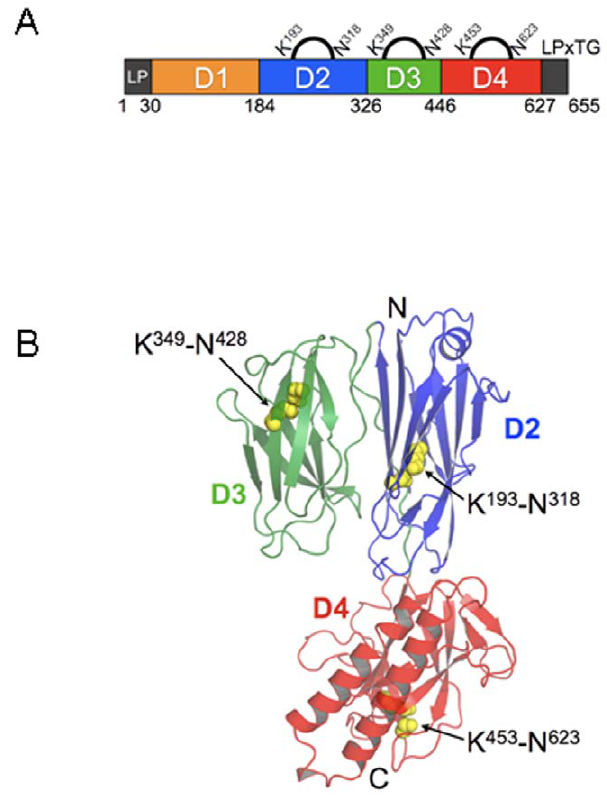
Figure 3. Structure of RrgB. A) Sequence organization of the full- length RrgB protein. D1 is depicted in yellow, while D2, D3 and D4 domains are respectively in blue, green and red. Position of the intra- molecular isopeptide bonds, the leader peptide (LP) and LPXTG motif are indicated. B) Ribbon Diagram showing the three domains of RrgB coloured as in A. Isopeptide bonds in each domain are shown as yellow spheres. Figure produced with Pymol (http://www.pymol.org/).